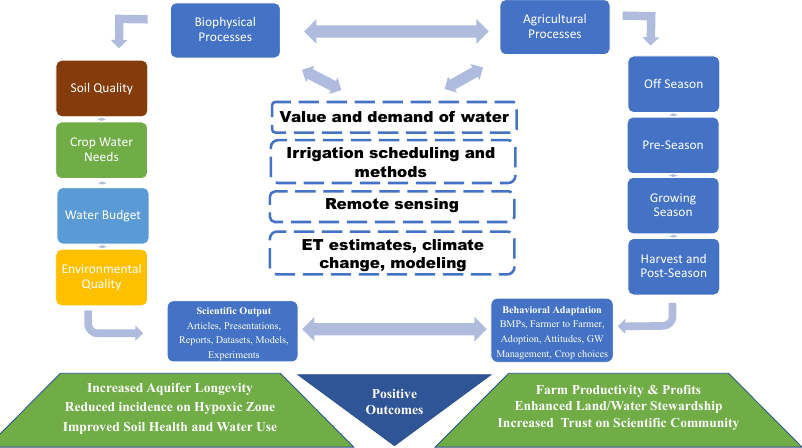
Figure 2. Flow chart depicting the how the agronomic or hydrogeologic data from soil, weather, geospatial, and water monitoring and management devices that are produced, processed, and analyzed by NCAAR researchers are converted to scientific publications and farm management recommendations via technology transfer. This also leads to decision support tools that allow producers leverage the wealth of data they generate from their